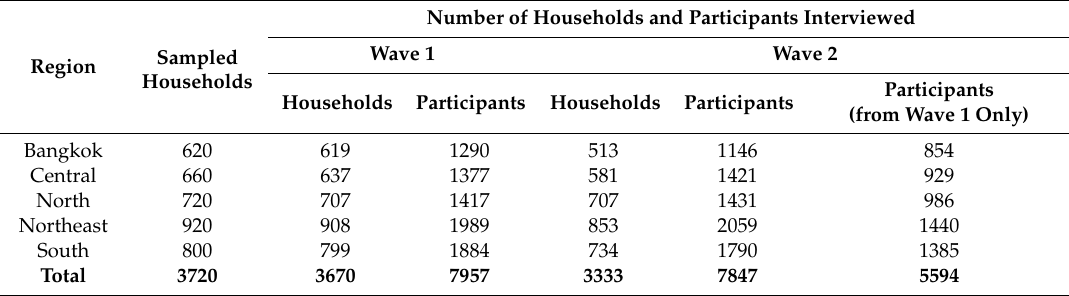
Table 1. Number of sample household members and response rate of the survey in Waves 1 and 2.